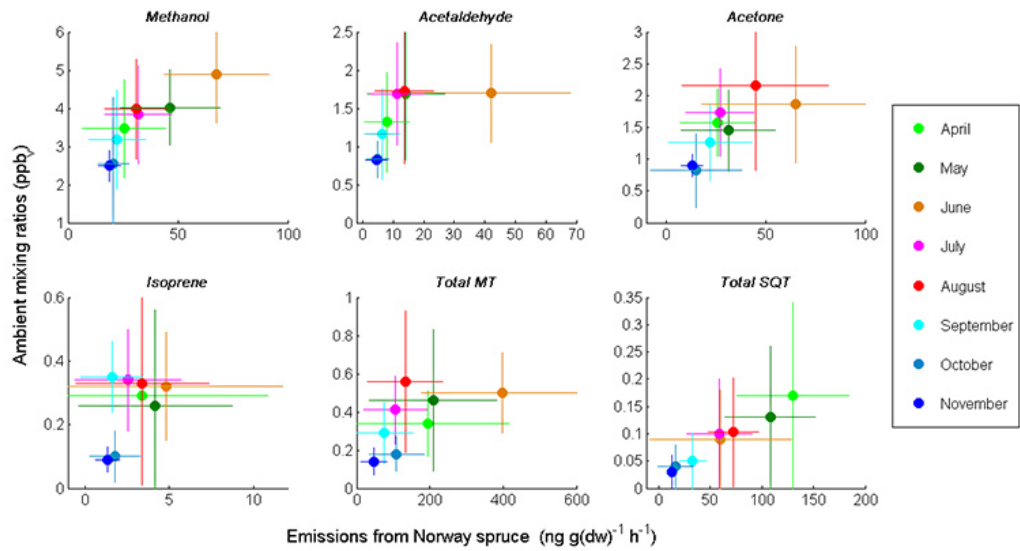
Figure 6. Monthly mean emissions from Norway spruce against the ambient mixing ratios. The linear fitting is in the form of y = ax + b , where y is the ambient mixing ratios and x the emissions. The parameters a and b are defined in the boxes of each plot. R 2 is the statistical result that expresses the quality of the fitting. Inside the brackets are the values obtained when considering all the